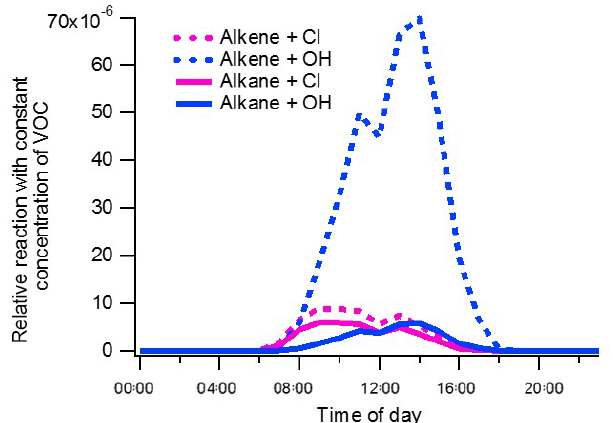
Figure 8. Mean diurnal time series of alkene (pink) and alkane (blue) relative reaction rate (arbitrary value) with the chlorine atom (dashed) and OH